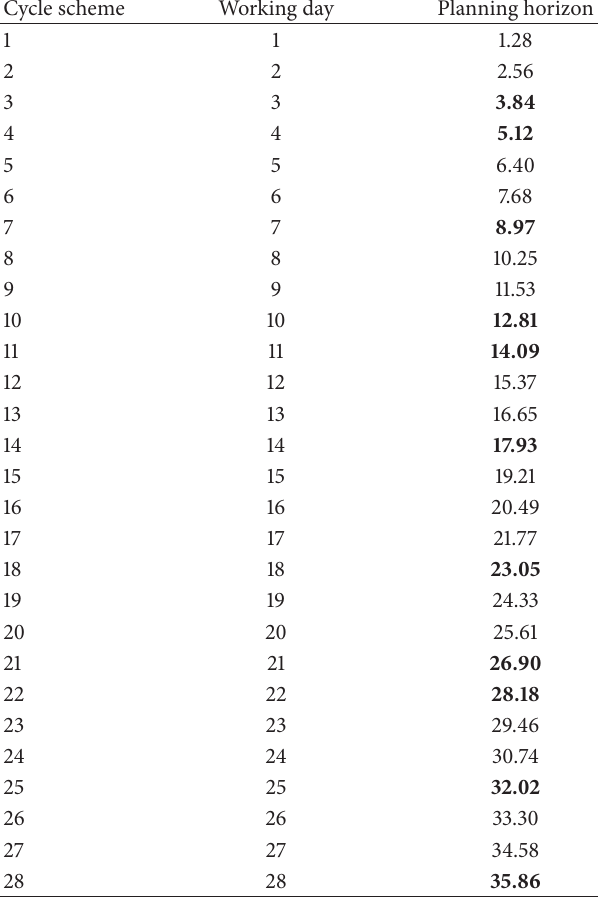
Table 2: Reasonable cycle schemes to be selected. Cycle